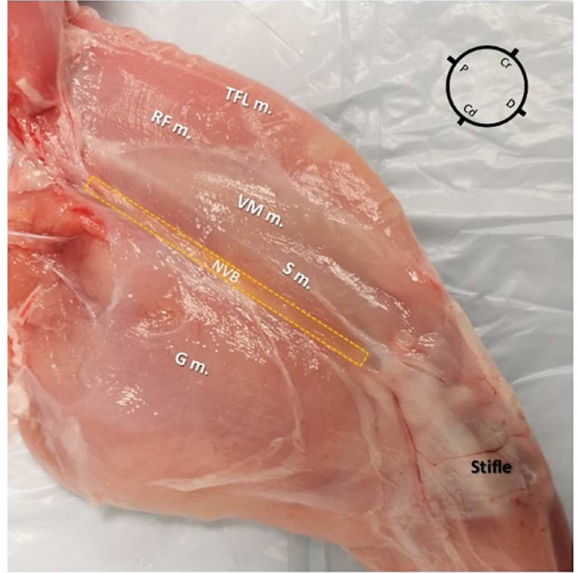
Figure 1. Skinned rabbit hind-limb positioned in dorsal recumbency with the hind-limb extended in a natural position for gross anatomical dissection (medial aspect of the left hind-limb). At the anterior aspect of the pelvic limb, the vastus medialis (VM m.), sartorius (S m.), rectus femoris (RF m.), and tensor fascia latae (TFL m.) muscles were identified. At the posterior aspect of the hind-limb the gracilis muscle (G m.) was identified. In the medial-center aspect of the thigh, a depression containing the neurovascular bundle (NVB) (yellow dotted lines area) was identified. P: Proximal; D: Distal; Cr: Cranial; Cd: